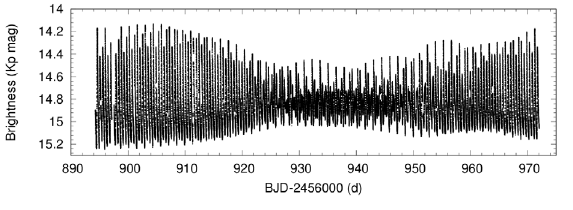
Figure 1: The short cadence light curve of EPIC 205209951 obtained with EAP photometry.